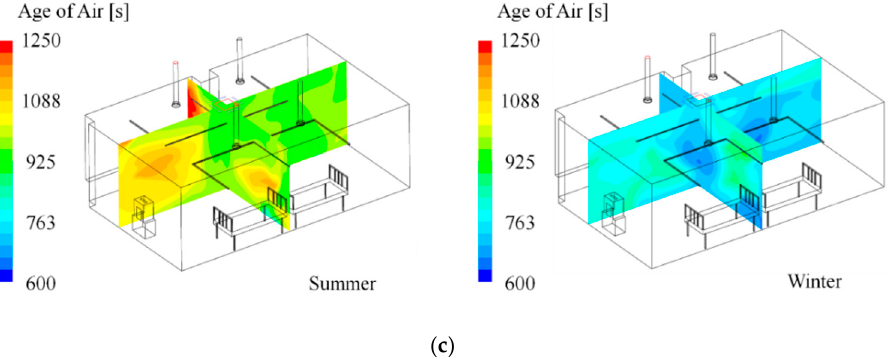
Figure 3. One of the simulation results ( left : Case S2 in summer, right : Case W2 in winter); ( a ) velocity contour; ( b ) temperature contour; ( c ) age of air contour.